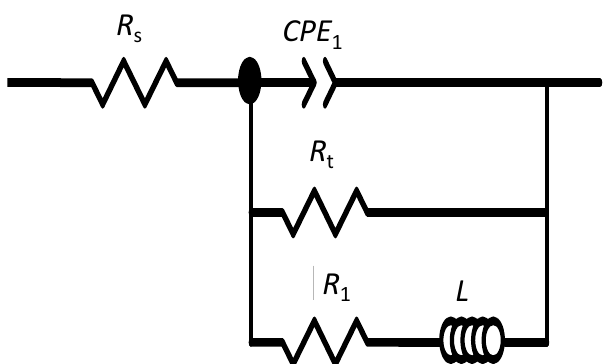
Figure 6. The equivalent circuit used for fitting experimental EIS spectra of AZ31B immersed in Ringer ′ s solution (37 °C).